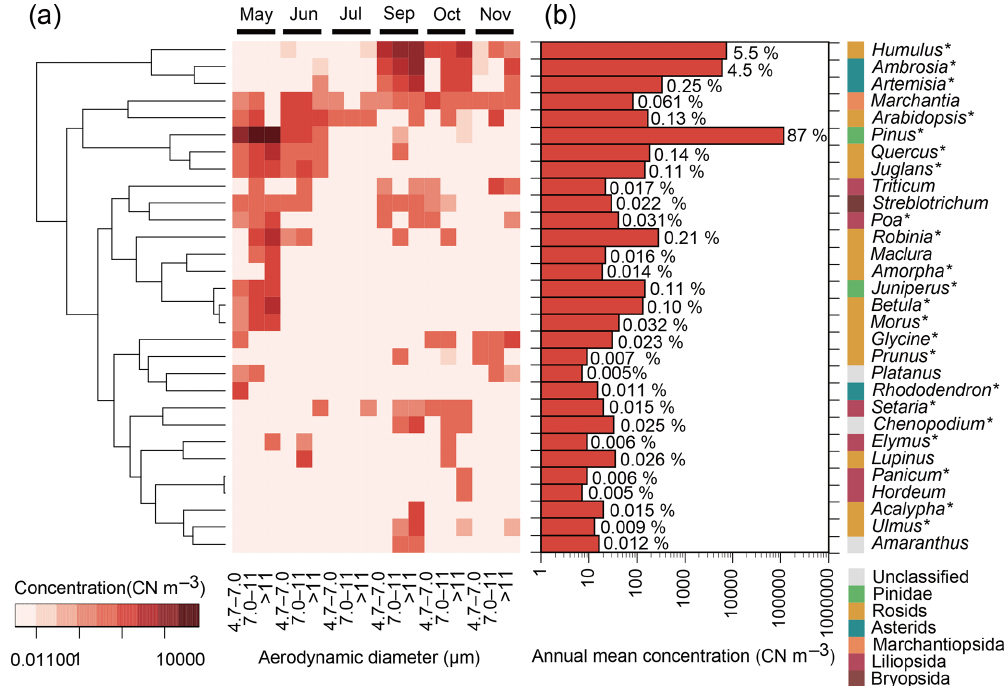
Figure 2. The 30 most abundant plant genera in terms of ITS2 copy number (CN) in atmospheric samples from Seoul in South Korea. Asterisks ( ∗ ) indicate spermatophyte genera that are known to inhabit South Korea and that are listed in the databases of the Korea Na- tional Arboretum (2017) and/or the Korea Research Institute of Bioscience and Biotechnology (2016). (a) Monthly particle size-resolved concentrations from May to November 2015 are shown, except for August when air sampling failed. The tree represents the similarities, based on Euclidean distance, of the log-transformed concentrations. (b) Annual mean particle size-integrated concentrations. Percentage values indicate relative contributions.